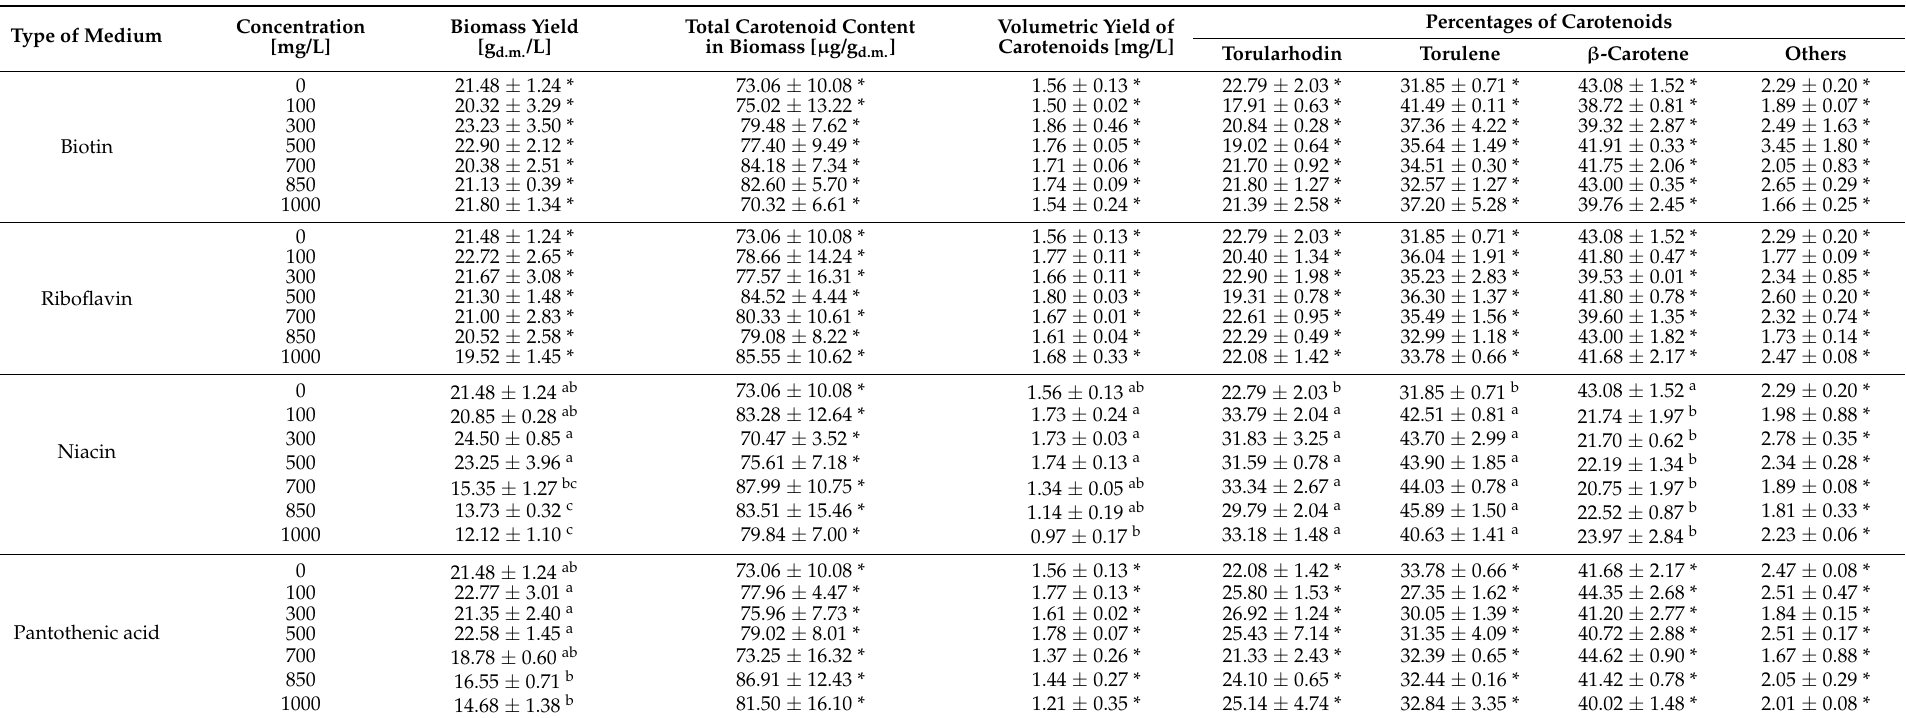
Table 4. Biomass yield and content and profile of carotenoids after 120 h of cultivation in media enriched with selected B vitamins. Percentages of Carotenoids Biomass Yield Total Carotenoid Content Volumetric Yield of Type of Medium Concentration [mg/L] [g d.m. /L] in Biomass [ µ g/g d.m. ] Carotenoids [mg/L] Torularhodin Torulene β -Carotene